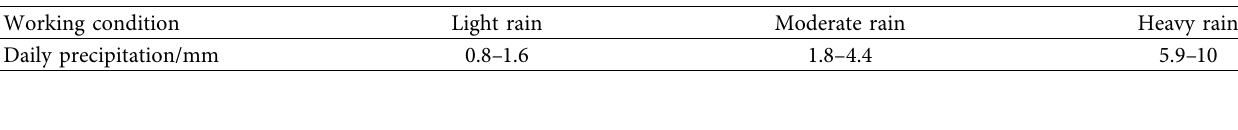
Figure 6: Schematic diagram of the model. Table 5: Daily rainfall grade.